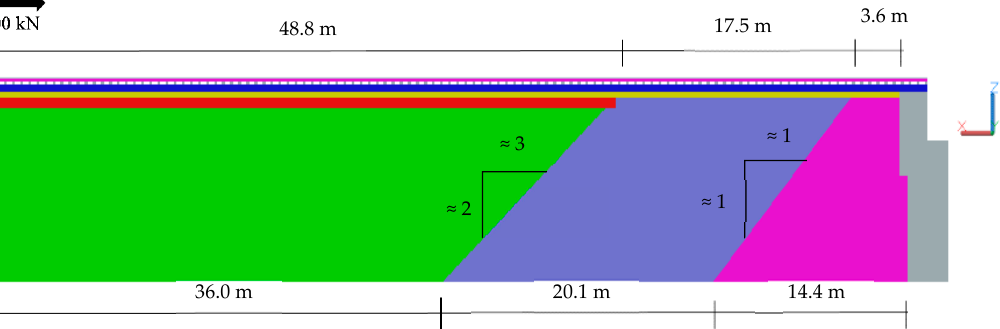
Figure 2. Longitudinal geometric arrangement and components with dimensions defined in the XZ plane for the base model with wedges and definitions of the mobile load and application direc- tion.